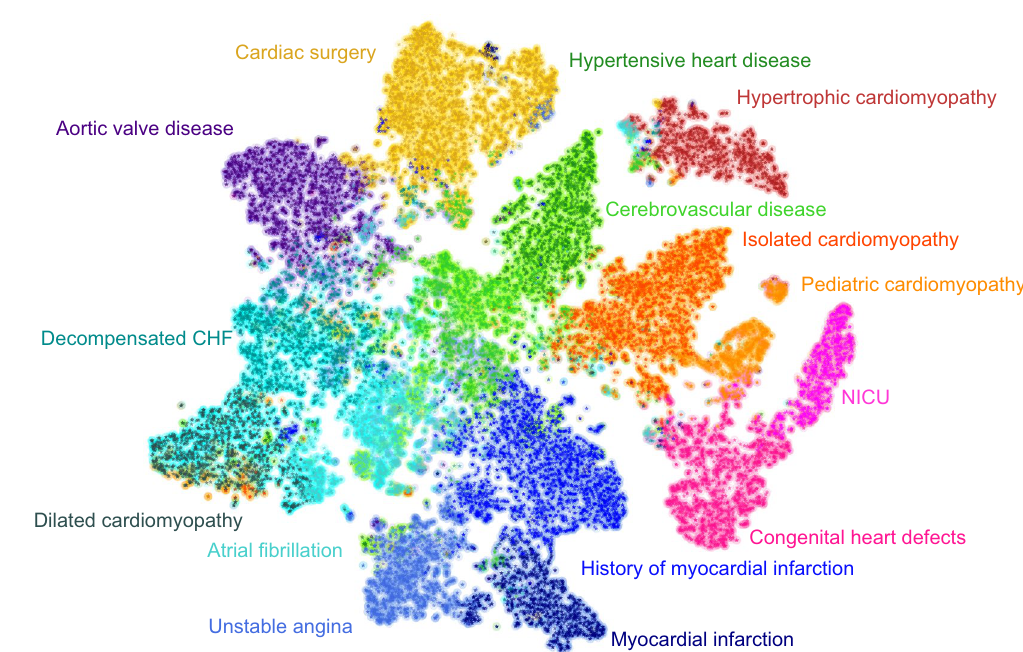
Figure 2. Exemplary 2D visualization of the relative distances between all patients EHRs in the heart failure cohort using t-SNE. Colors show cluster assignment using K-means clustering (K = 15). Each cluster is shown with an interpretable name defining the heart failure